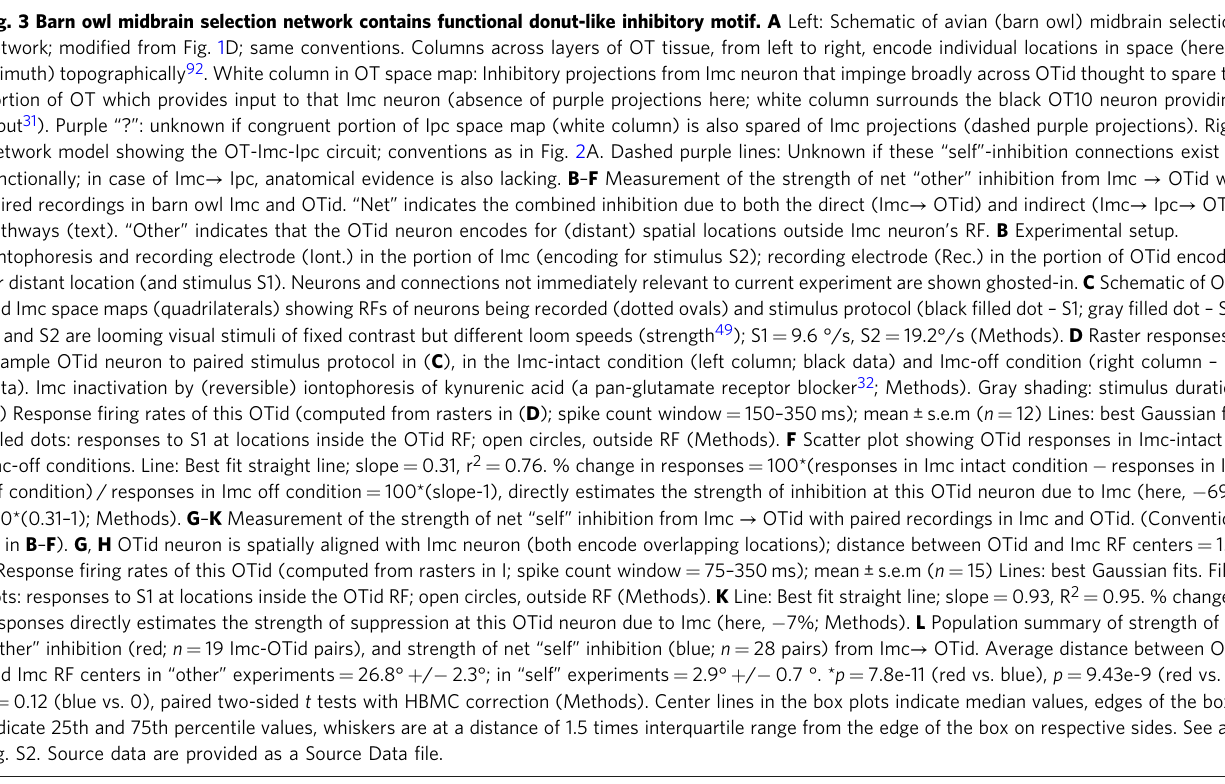
Fig. S2. Source data are provided as a Source Data fi